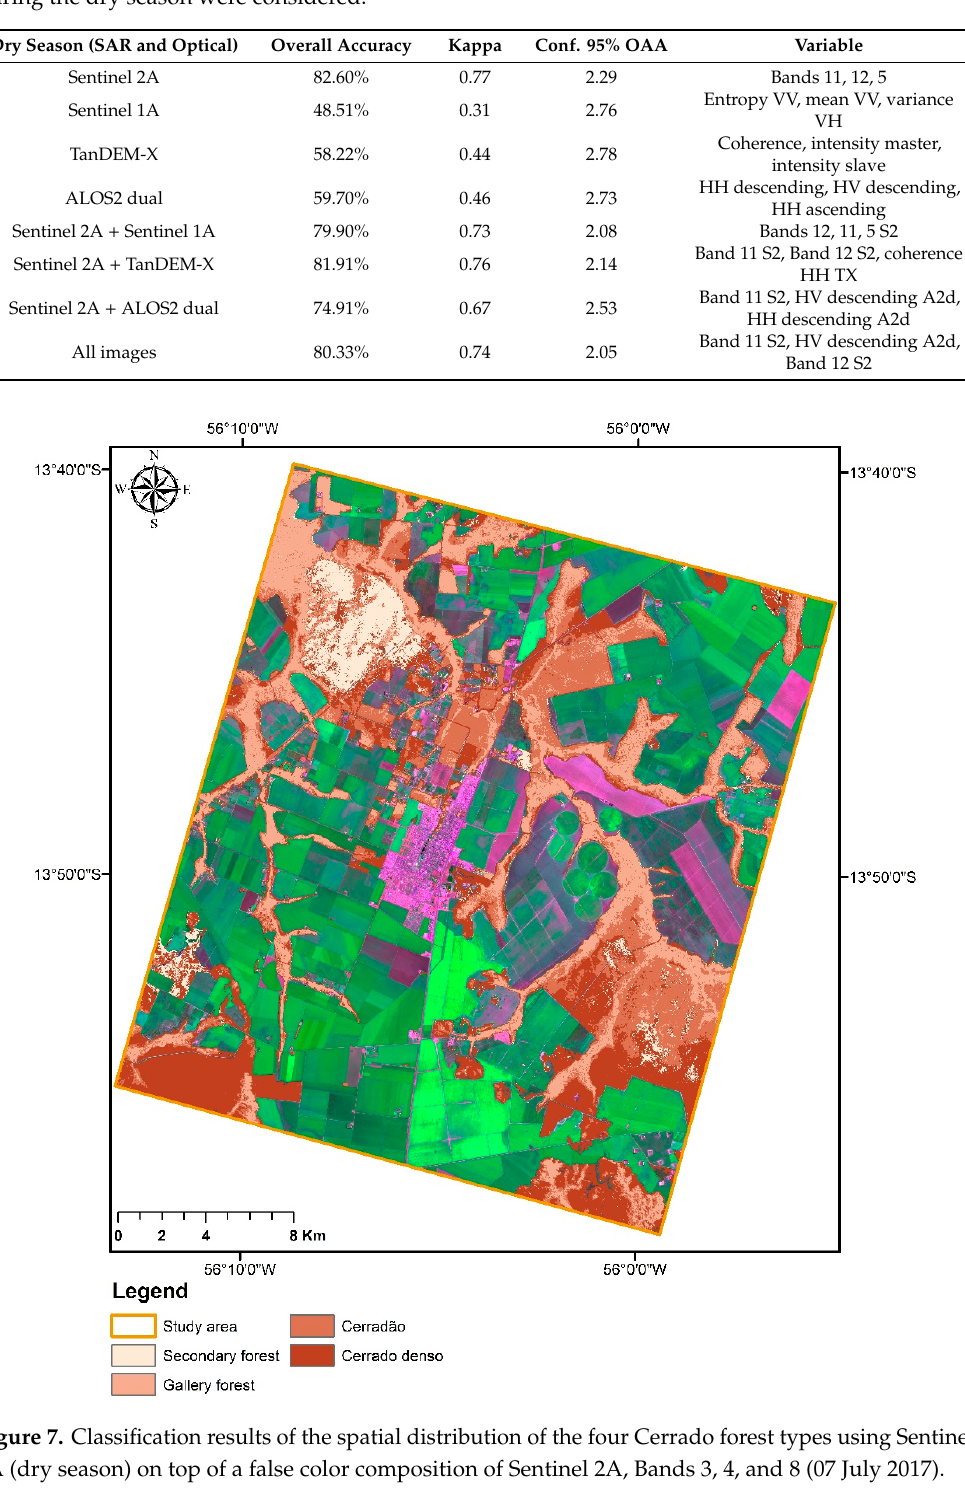
Table 3. Overall accuracy, kappa, confidence interval 95%, overall average accuracy (OAA), and the three most important variables for the classifications based on the Random Forest variable importance for Sentinel 2A (S2), ALOS PALSAR 2 full (A2f), ALOS PALSAR 2 dual (A2d), TanDEM X (TX), and Sentinel 1A (S1). The parameters listed in the variable importance are the PC1 derived from the PCA, except for the images from TanDEM-X, as only one acquisition was available. Only data acquisitions during the dry season were considered.